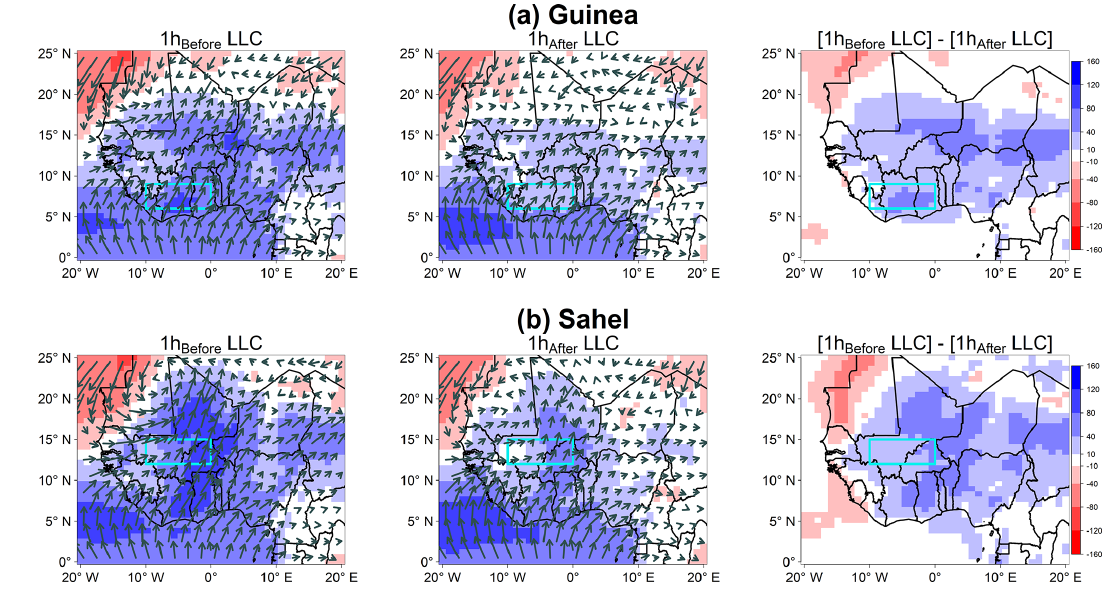
Figure 7. Composites of 950hPa moisture flux (colors, gkg − 1 ms − 1 ) and wind (vectors, ms − 1 ) over WA for the hour preceding LLC Class-2 occurrence (1h Before LLC) and after it disappears (1h After LLC) and the difference between the two periods during JAS from 2006 to 2015. Wind vectors are averaged over two grid points in both the x and y